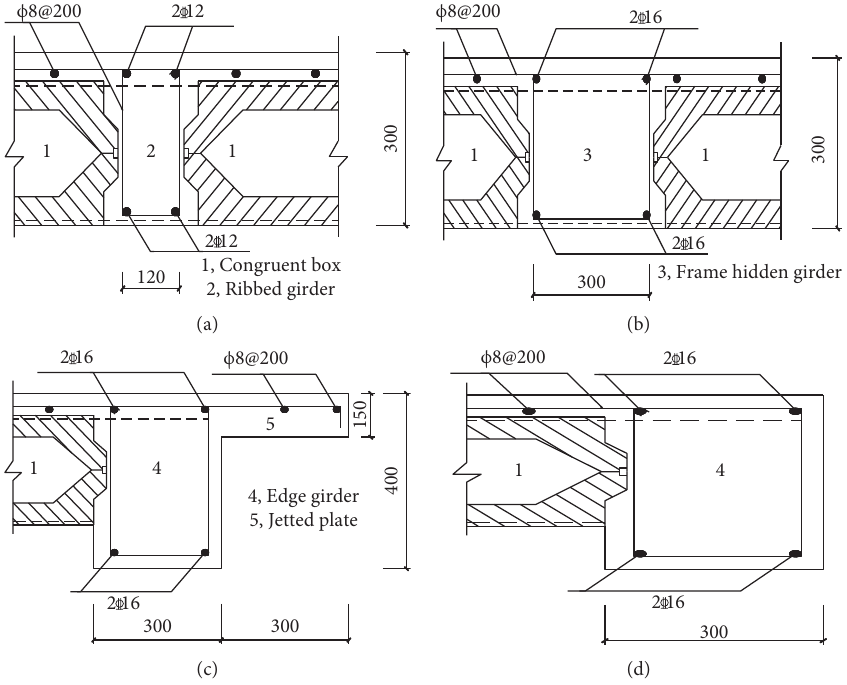
Figure 5: Sketch map of the AMH slabs. (a) Ribbed girder; (b) frame hidden girder; (c) edge girder with jetted plate; (d) edge girder without jetted plate.